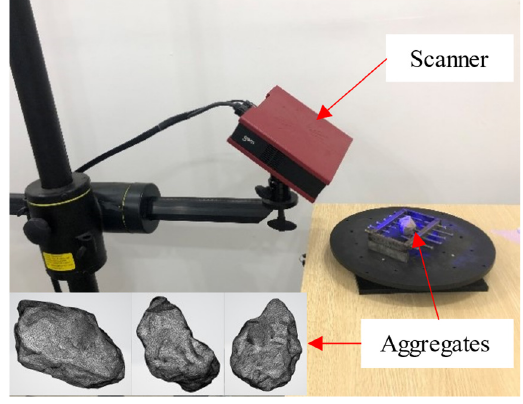
Figure 5. The laser scanner.